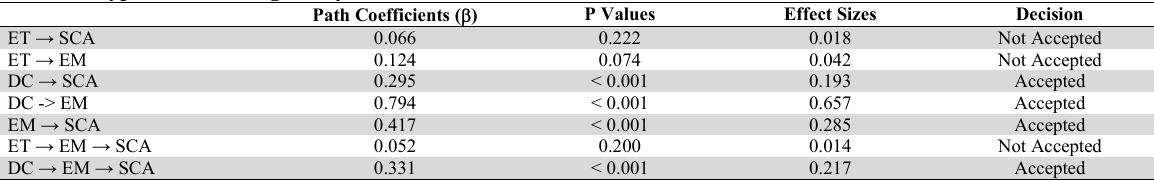
Result of Hypothesis Testing